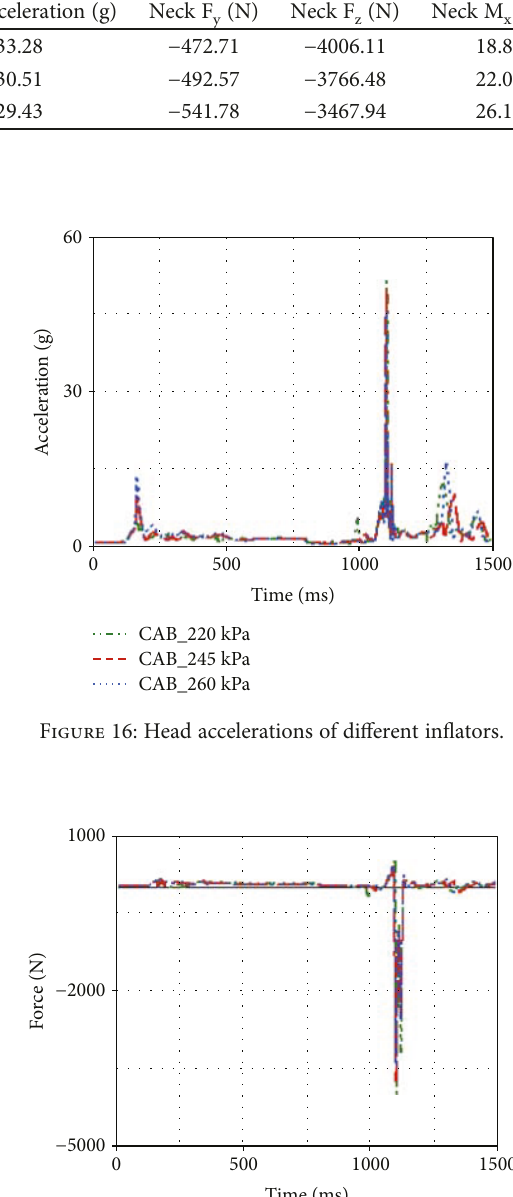
of di ff erent in fl z